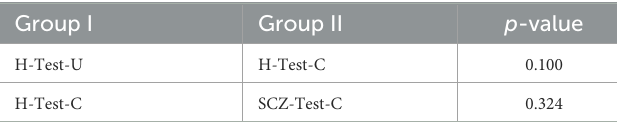
TABLE 4 Mann-Whitney test between the MSE s values data of the groups of subjects, for the COBRE